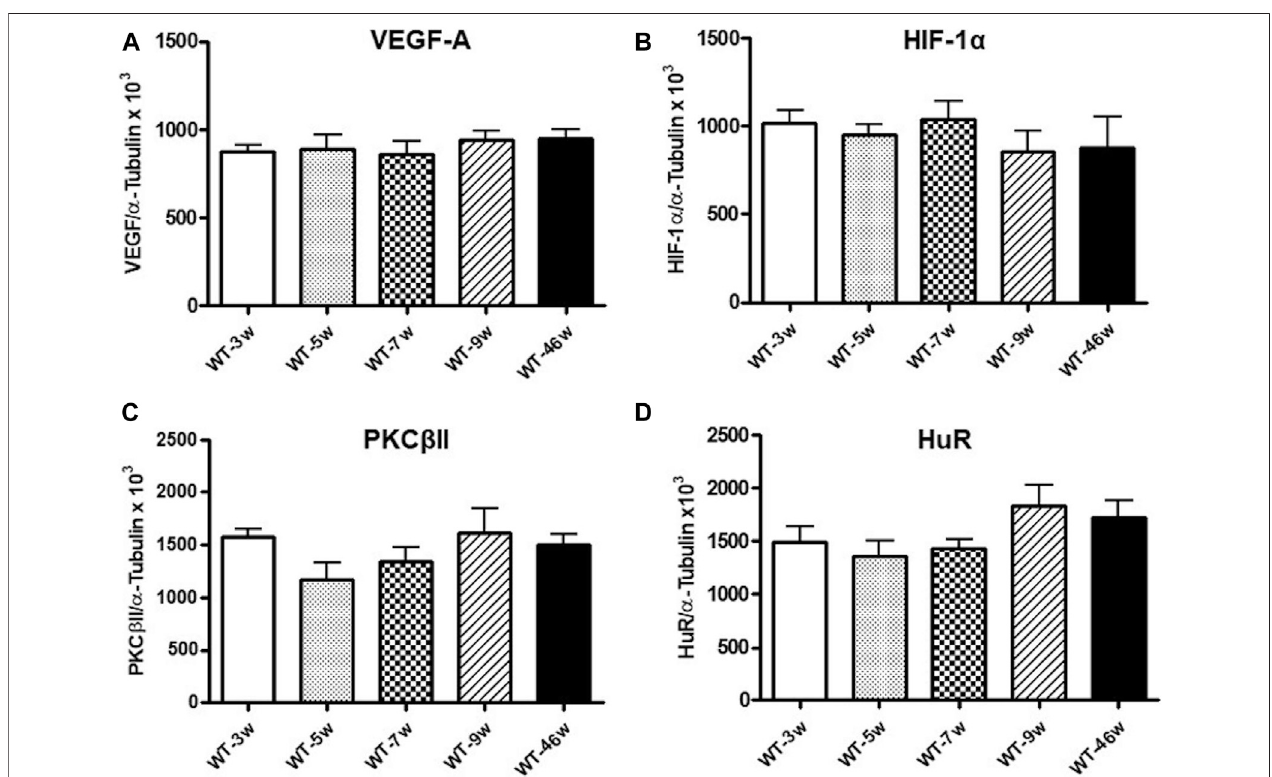
FIGURE 3 | VEGF-A, HIF-1 α , PKC β II and HuR protein levels in wild-type mice at different ages. Densitometric analysis of VEGF-A 164 (A) , HIF-1 α (B) , PKC β II (C) , and HuR (D) immunoreactivities in the total homogenatesof retinae from wild-type (WT) mice at different ages (w (cid:2) weeks). Alpha-tubulin wasused asa loading control. Results are expressed as mean grey levels ratios x 10 3 (mean ± S.E.M.) of VEGF-A 164 / α -tubulin (A) , HIF-1 α / α -tubulin (B) , PKC β II/ α -tubulin (C) and HuR/ α -tubulin (D) immunoreactivities measured by Western blotting, n (cid:2)